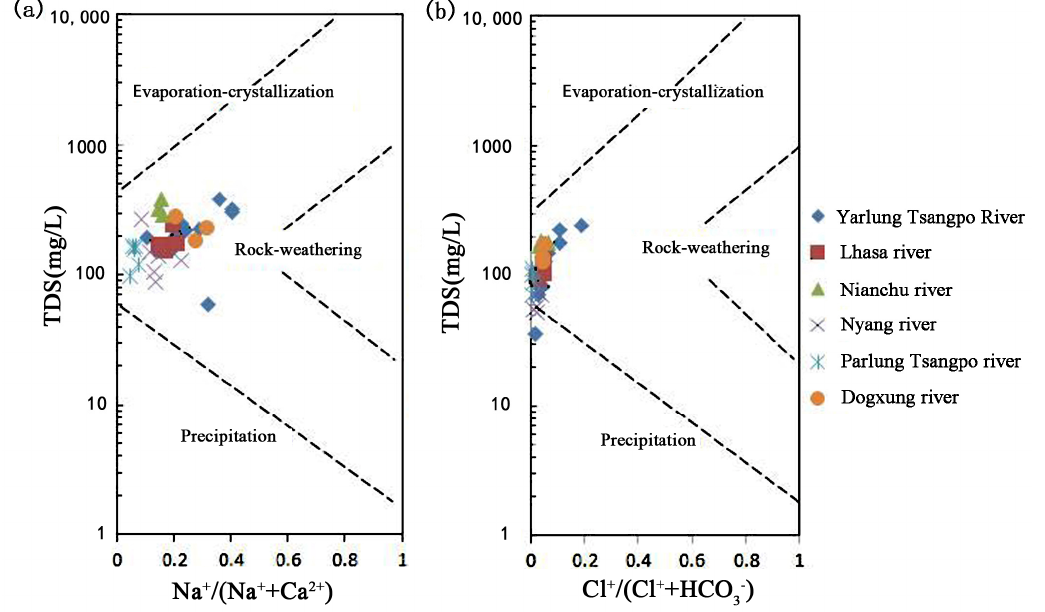
Figure 6. Gibbs plots of concentrations ratios of ( a ) TDS versus Na + /(Na + + Ca 2+ ) and ( b ) TDS versus Cl − /(Cl − + HCO 3 − ) for the Yarlung Tsangpo River basin and its tributaries. Each symbol corresponds to streams from the main tributaries analyzed in this study: the Lhasa river, Nianchu river, Nyang river, Parlung Tsangpo and Dogxung.